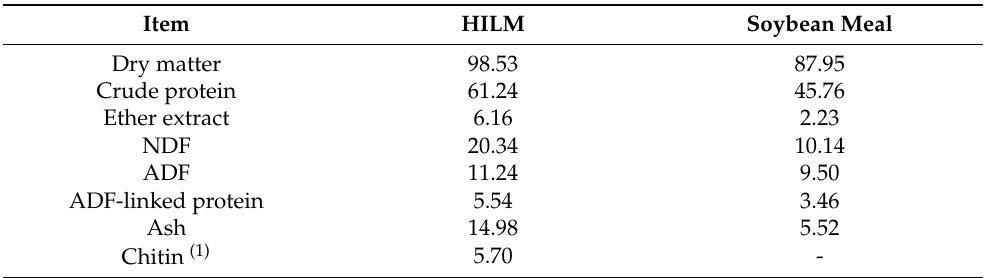
Table 2. Chemical composition (%) of Hermetia illucens larvae meal (HILM) and soybean meal. Item Dry